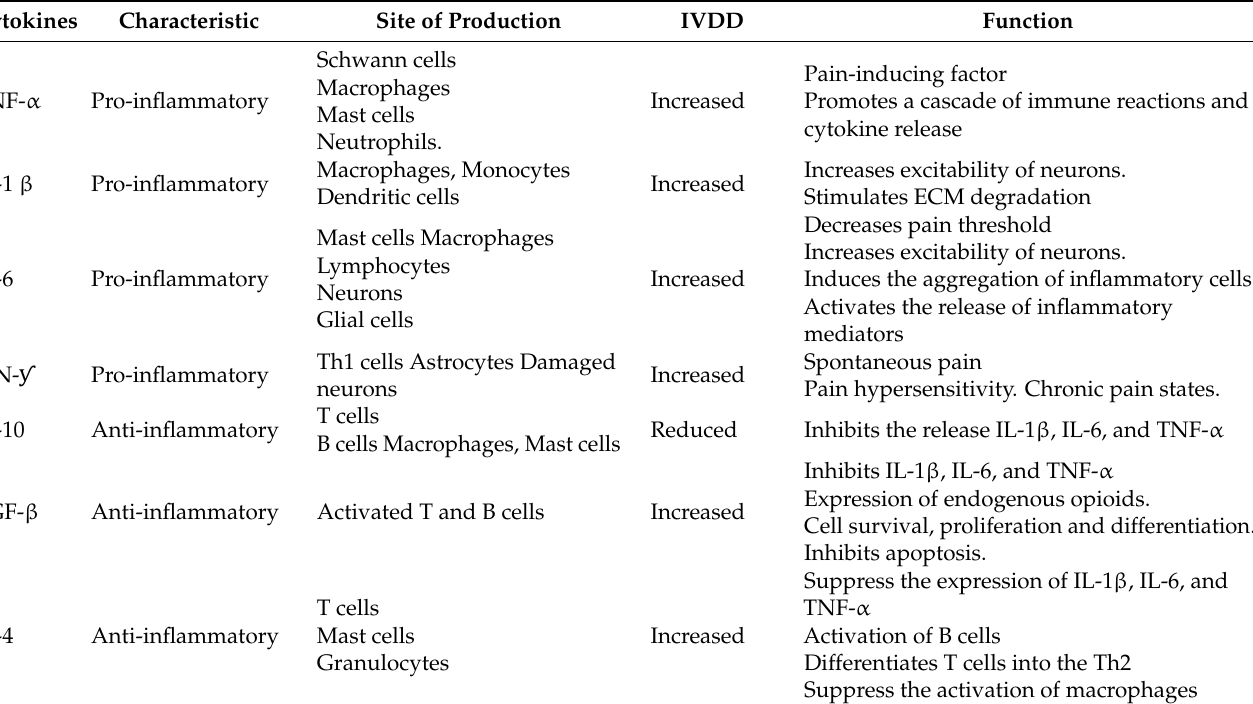
Table 1. Characteristics, function and site of production of Proinflammatory and anti-inflammatory cytokines